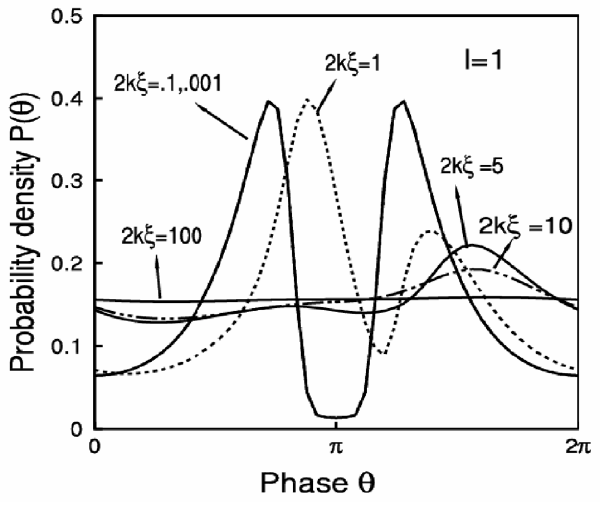
Figure 6. Phase θ distribution P ( θ ) against the disorder parameter 2 k ξ for a fixed sample length l = 1. RPA validation range: It is clear from the P ( θ ) distributions, that the random phase approximation (RPA) is valid for the condition ξ > λ = 2 π / k , where λ is the wave length of the incoming wave and ξ is the localization length. This has been checked systematically in our numerical calculations. When 2 k ξ ~ 10, the P( θ ) distribution is already deviating from RPA. 3.3.2. The Phase ( θ ) Distribution P( θ ) in the Asymptotic Limit of Large Lengths L → α Solution of the FP equation (Equation (12)) gives the full probability distribution P ( r , θ )